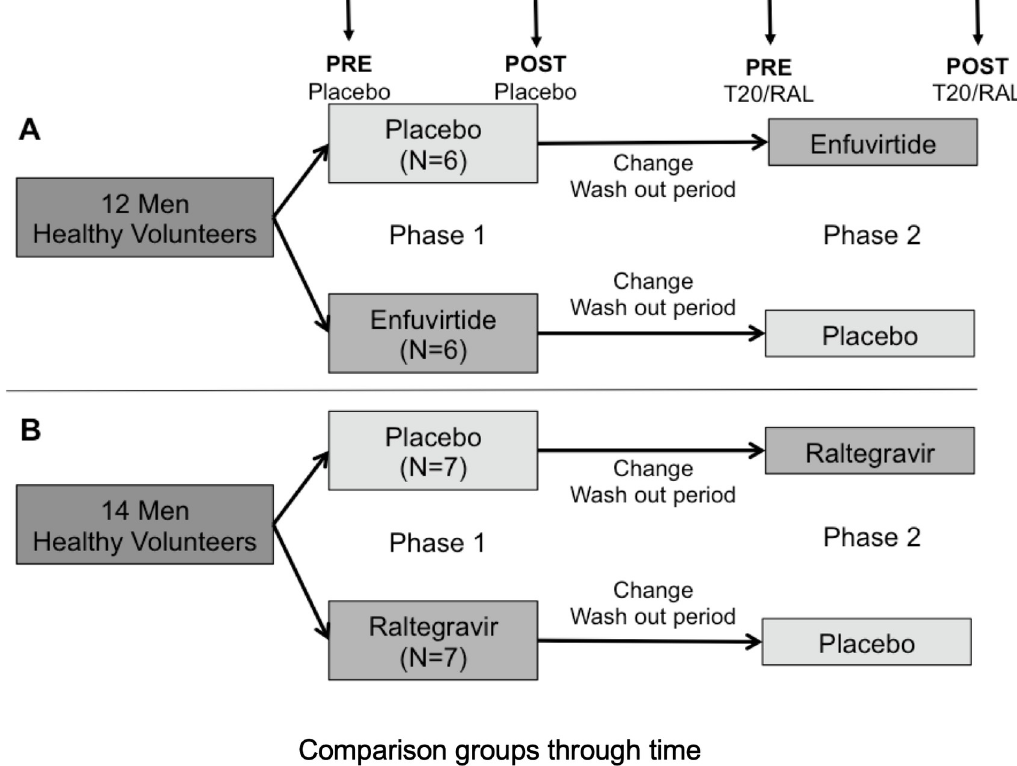
Fig 1. A: Flow diagram of enfuvirtide crossover. From a total of 12 healthy volunteers; 50% were randomized to placebo/ enfuviride sequence. B: Flow diagram of raltegravir crossover. From a total of 14 healthy volunteers; 50% were randomized to placebo/raltegravir sequence. Blood samples (upper arrows) were obtained before (PRE) and after (POST) both phases. Each phase was 1 week long, separated from each other by a washout period of four weeks. Volunteers started with phase 1 trial (placebo/treatment) followed by a washout period and posterior phase 2 (treatment/placebo, according to the first made